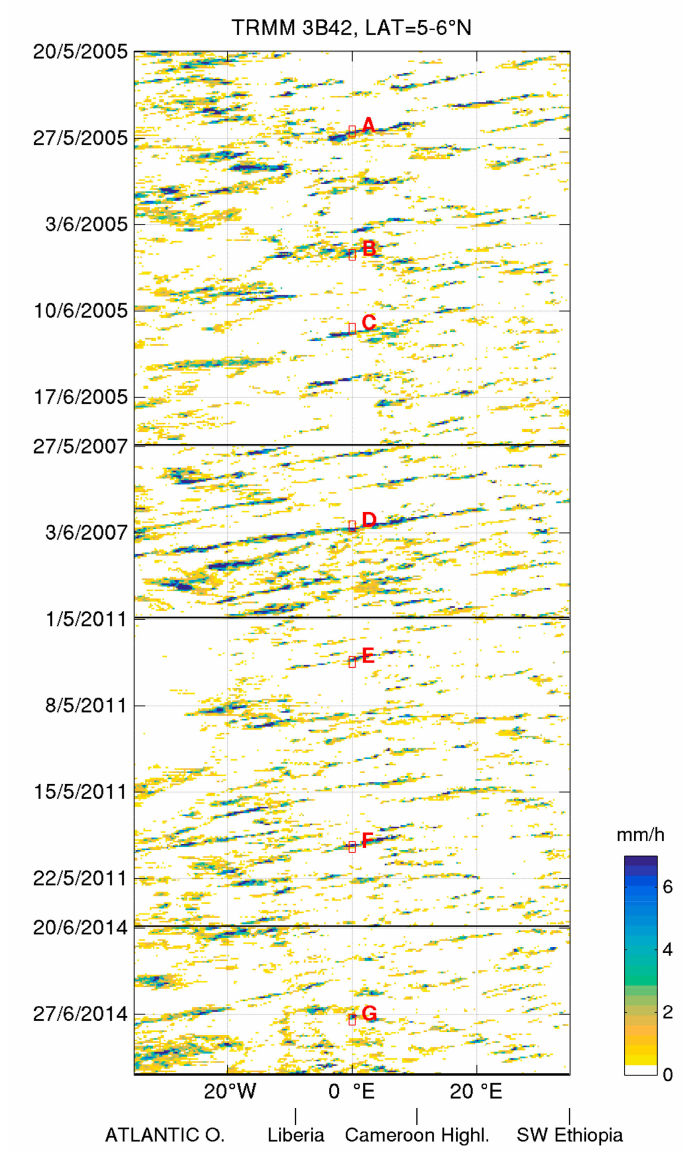
Figure 9. Hovmöller diagram of 3-hour TRMM 3B42 rainfall along latitude 5–6 ◦ N for a sample of area 5–6 ◦ N, 0.5 ◦ W–0.5 ◦ E). The intense rainfall events are shown as red squares and